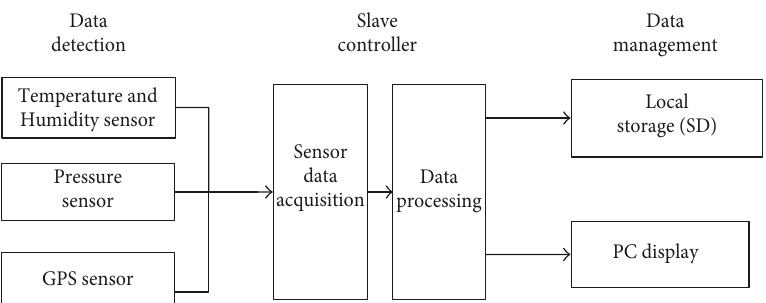
Figure 11: Meteorological element detection system structure